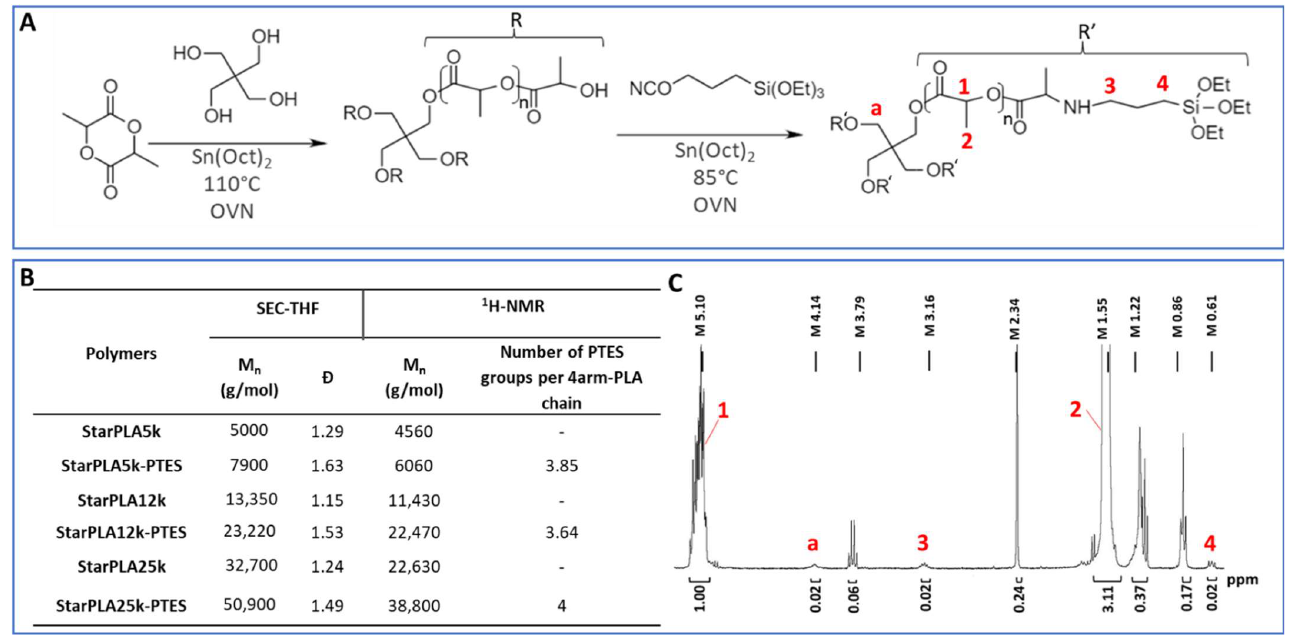
Figure 1. Synthesis and characterization of StarPLA and tetra(triethoxysilyl) StarPLA: ( A ) General synthesis and functionalization reactions; ( B ) 1 H-NMR and SEC characterization of StarPLA and tetrafunctionalized StarPLA; ( C ) 1 H-NMR spectrum of StarPLA25k-PTES.